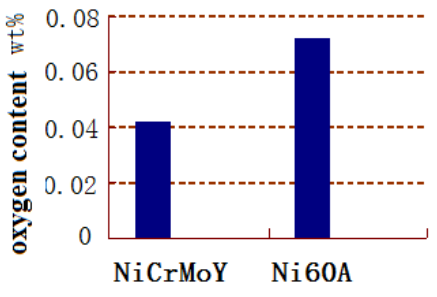
Figure 5. The oxygen content of the powders.